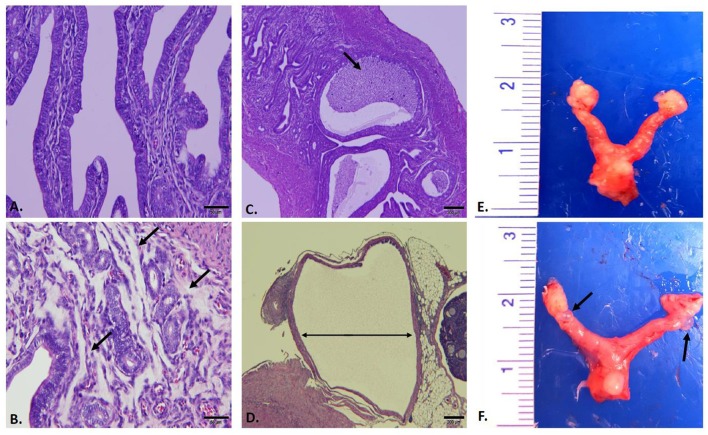
Gross and Histopathological Assessment of Reproductive Tracts Post Infection. Mice (n = 3 per group) were euthanized 59 days post infection and entire reproductive tracts were removed for gross assessment followed by formalin fixation for histological evaluation. Images of H&E stained sections of uterine tissue were captured using an Olympus DP70. (A) Sham infected uterine tissue (20X). (B)
C. trachomatis serovar D-LC infected; arrows to areas of mucinous inflammation (20X). (C)
C. trachomatis serovar L2 infected; arrows to areas of luminal inflammation (4X). (D)
C. muridarum MoPn infected; arrow indicating oviduct dilation (4X). (E) Sham infected whole reproductive tract. (F)
C. muridarum MoPn infected whole reproductive tract; arrows to areas displaying hydrosalpinx. See Table 1 for pathological scoring and morphometric measurements of reproductive tracts.